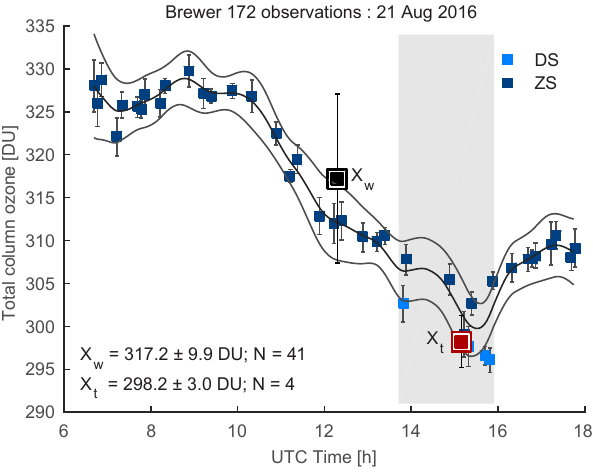
Figure 1. Example day showing valid DS and ZS observations and their standard deviations. Also shown are the daily representative value based on the traditional (arithmetic mean, DS>ZS prefer- ence) methodology (red outlined square, X t ) and the daily repre- sentative value formed through the method described herein (black outlined square, X w ) . The shaded area shows the time coverage for data points contributing to the traditional estimate of the BRDV, and N is the number of contributing observations to each BRDV